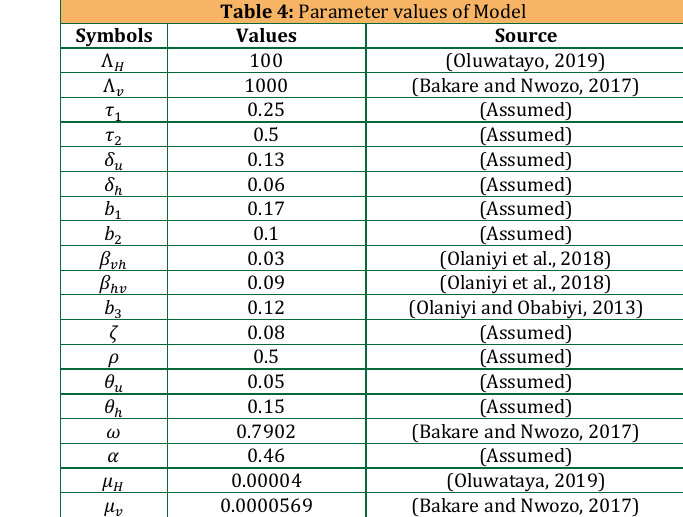
Table 4: Parameter values of Model